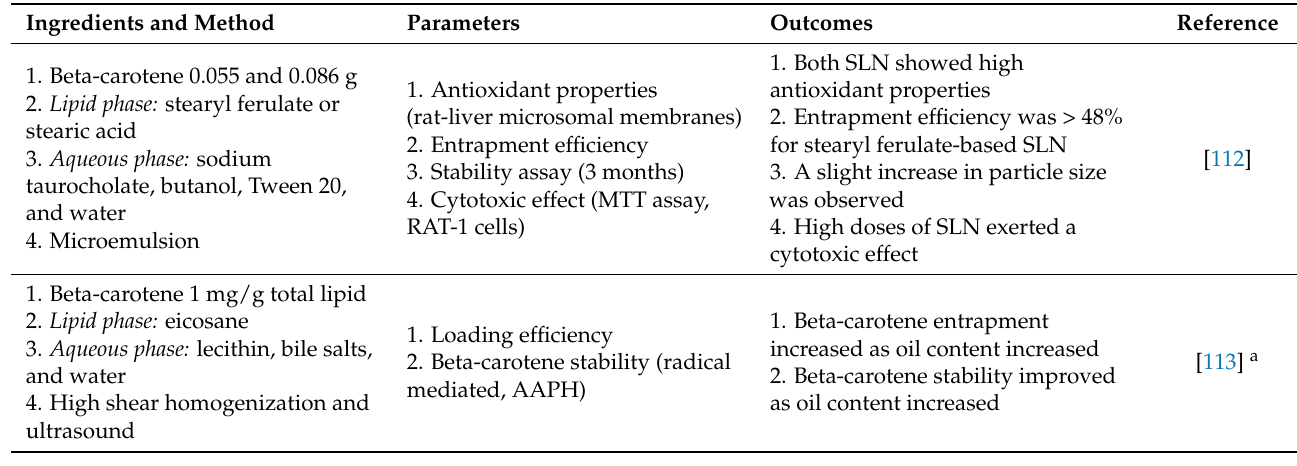
Table 2. Studies on carotenoid encapsulation in solid lipid nanoparticles (SLN) employing other preparation methods. Ingredients and